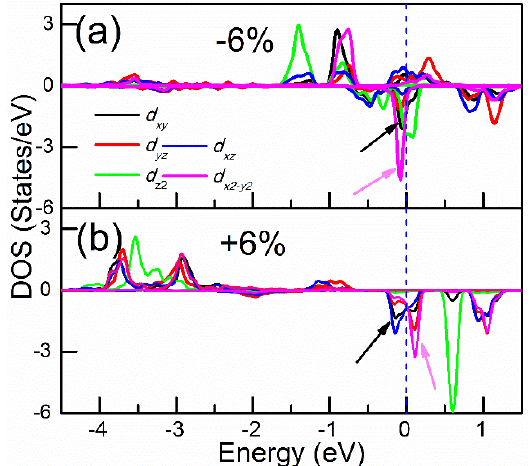
Figure 8. The partial density of states for Fe in − 6% ( a ) and + 6% ( b ) strains in C-1 stacking configuration. The di ff erent orbitals are presented by di ff erent colors provided in the figure. The black and pink arrows highlight the changes of the corresponding states. The vertical dashed blue line shows the position of the E F